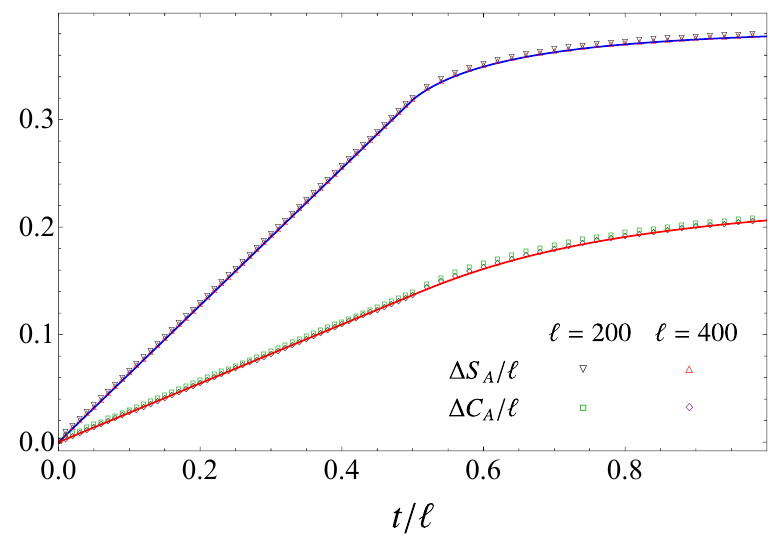
Figure 7 . Temporal evolution of ∆ S A and ∆ C A of a block of ‘ consecutive sites in the infinite free fermionic chain after a global quench from the fully dimerised chain to the homogeneous gapless chain. Two different values of ‘ are considered. The blue and the red solid lines are obtained from (4.9) and (4.10) respectively, by using (4.18), (4.32) and